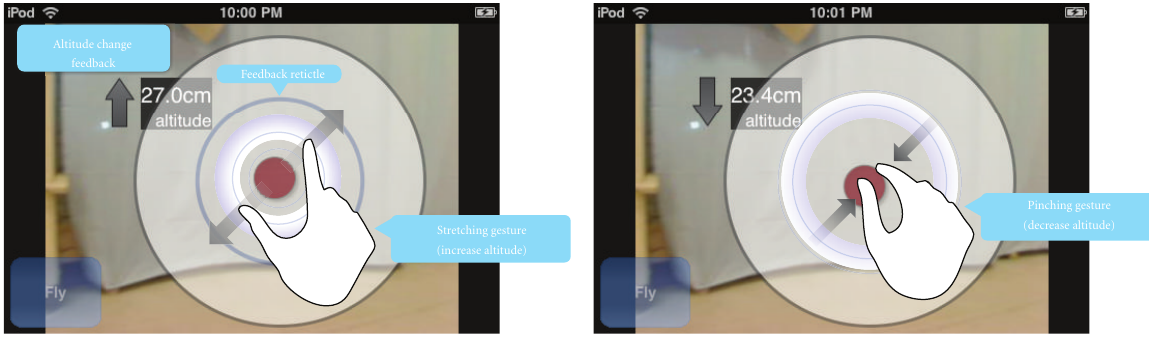
Figure 6: Interface feedback as a result of the operator performing a tilt gesture with the device.